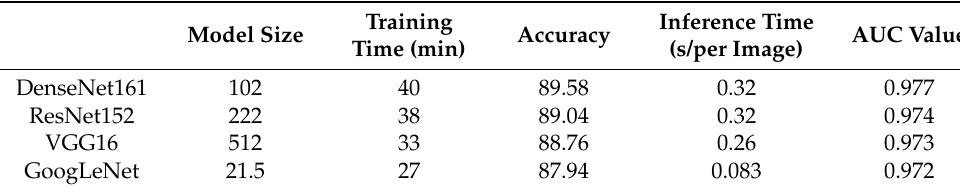
Figure 2. Training results for the four candidate CNN models. DenseNet161 had the highest accuracy. ( a ) DesneNet161; ( b ) ResNet152; ( c ) VGG16; ( d ) GoogLeNet. The horizontal axis of the graph represents the training epochs. The left vertical axis of the graph represents the classification accuracy, and the right vertical axis of the graph represents the loss value. Table 2. Model size, training time, classification accuracy, inference time, and AUC value of the four